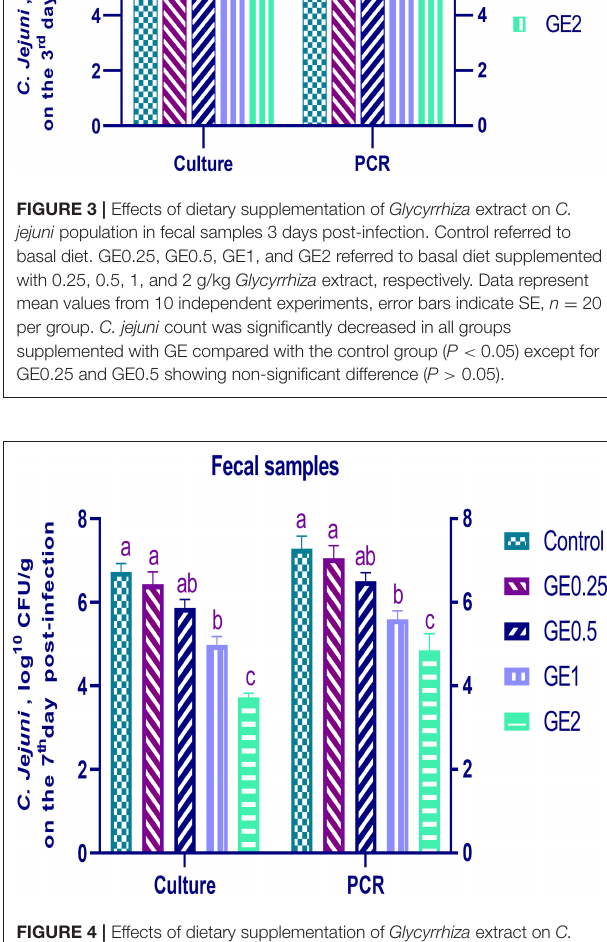
FIGURE 4 | Effects of dietary supplementation of Glycyrrhiza extract on C. jejuni population in fecal samples 7 days post-infection (Culture and RT-qPCR). Control referred to basal diet. GE0.25, GE0.5, GE1, and GE2 referred to basal diet supplemented with 0.25, 0.5, 1, and 2 g/kg Glycyrrhiza extract, respectively. Data represent mean values from 10 independent experiments, error bars indicate SE, n = 20 per group. C. jejuni count was significantly decreased in groups supplemented with 1 and 2 g/kg GE compared with the control group ( P < 0.05).